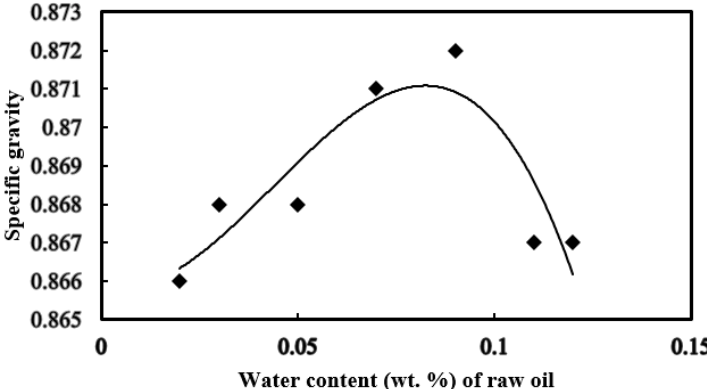
Figure 4. Effects of added water content in palm oil on the specific gravity of the biodiesel